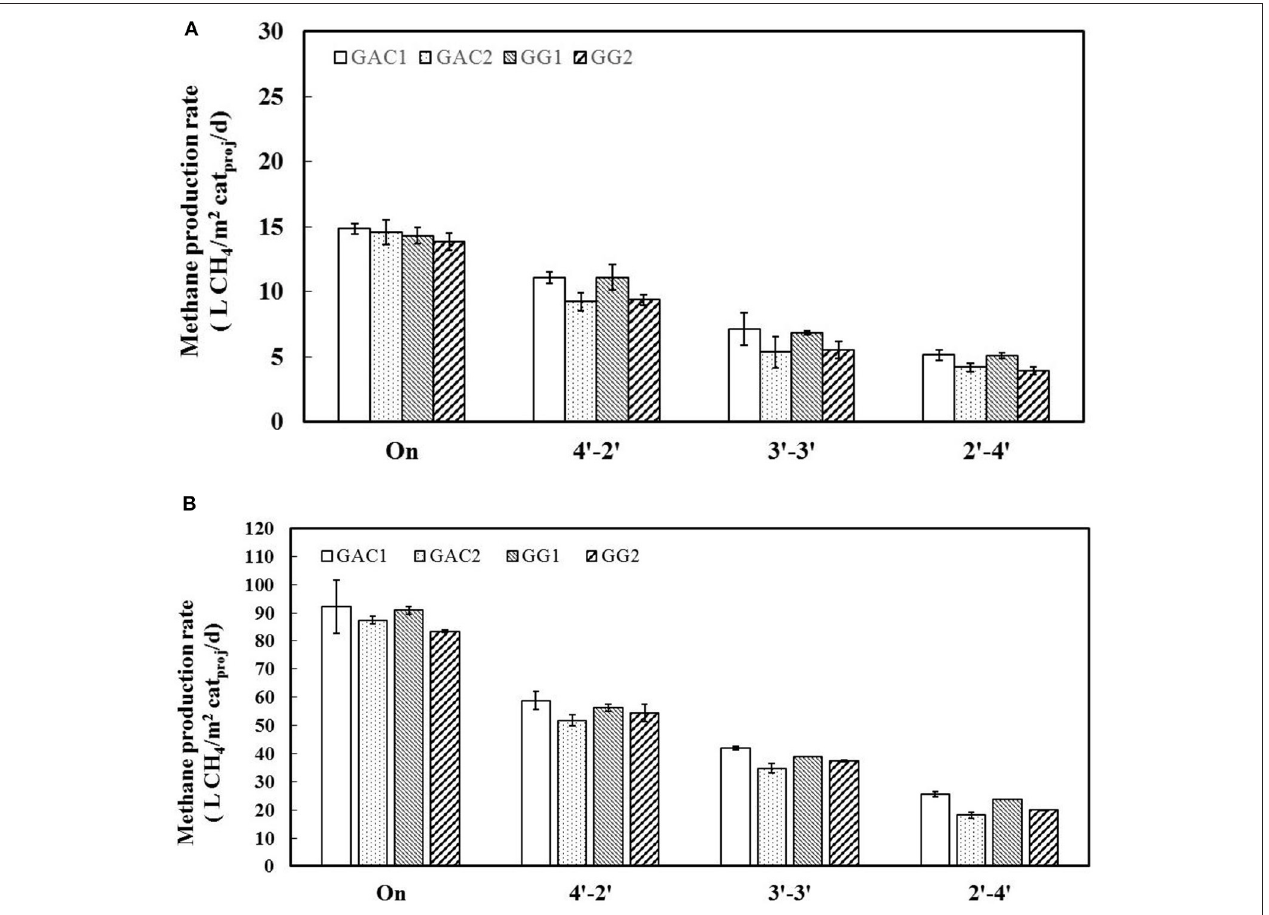
FIGURE 3 | Methane production rates for all biocathodes when they were supplied with constant current and intermittent current. Three different current time-ON/time-OFF intervals (4–2 ′ , 3–3 ′ , and 2–4 ′ ) were carried out. The current density during the current time-ON was 10 A/m 2 cat proj (A) and 35 A/m 2 cat proj (B) . For each operational condition, duplicate experiments were performed. The standard deviations are shown as an error bar, whereas the average value is shown as a